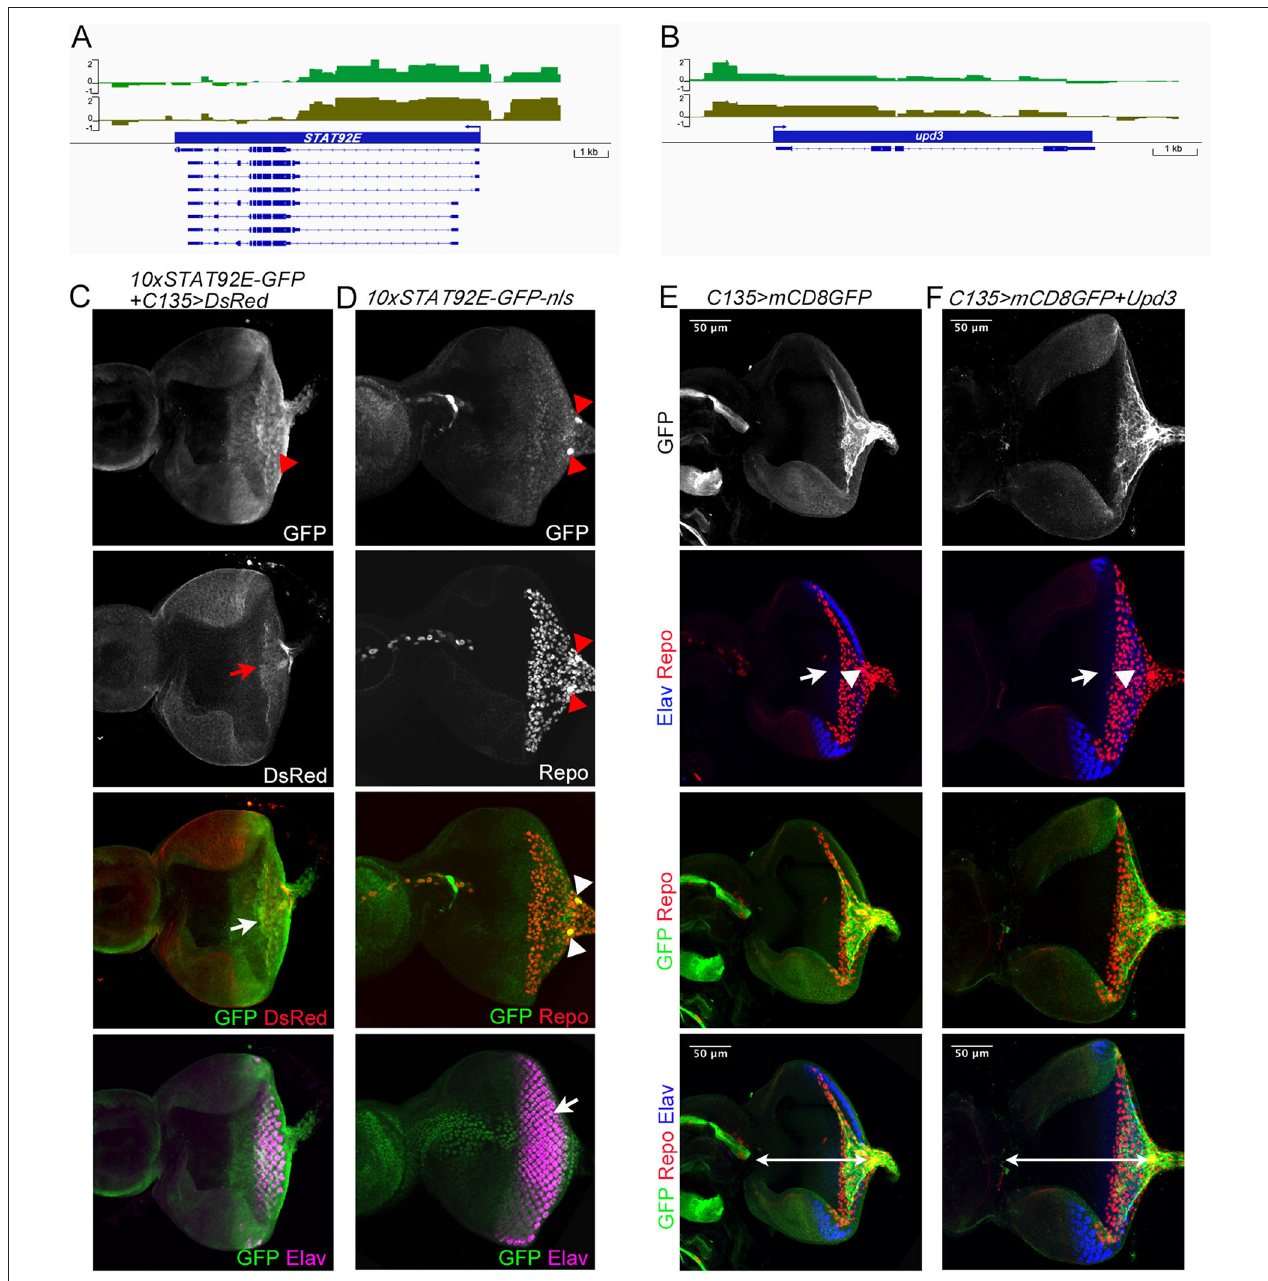
FIGURE 6 | Characterization of Dam-Pol II-bound genes: STAT92E and upd3 . (A,B) Dam-Pol II occupancy in the STAT92E (A) and upd3 (B) loci. Both biological replicates are shown in light and dark green. Scale bars on the y -axis represent the log 2 ratio change between Dam-Pol II and Dam samples. (C) A STAT92E activity reporter containing 10 STAT92E binding sites (10 × STAT92E-GFP) was crossed with C135-Gal4 driving UAS-DsRed labeling the membrane of carpet glia. GFP is expressed in the cytoplasm. The disc shown is a z-projection image and stained for the presence of GFP (green), DsRed (red), and Elav labeling differentiated PRs (magenta). The red arrowhead indicates the GFP punctate. The red arrow indicates the carpet glia membrane, and the white arrow indicates the colocalization of GFP and DsRed signals. (D) A modified STAT92E activity reporter whose GFP reporter is nucleus localized (10 × STAT92E-GFP-nls). The disc shown is stained for the presence of GFP (green), Repo (red), and Elav (magenta). The merged GFP and Repo image is a z-projection of basal focal planes, and the merged GFP and Elav image is the same eye disc with a z-projection of apical focal planes. Red and white arrowheads indicate the carpet nuclei. The white arrow indicates the colocalization of GFP and Elav signals. (E,F) All discs stained for the presence of carpet glia membrane (GFP staining, green), glial nuclei (Repo staining, red), and differentiated PRs (Elav staining, blue). Upd3-expressing eye discs (F) and control discs (E) at similar developmental stages (mid-third instar) are compared for disc size, which is measured by the length of the disc midline indicated by the white line. Upd3-expressing discs: 153 ± 2.7 µ m, n = 10; control discs: 126 ± 3.6 µ m, n = 8 (mean ± SD, n = disc number, p < 0.001, Student’s t -test). Rows of images are arranged as Figure 4 . White arrows and arrowheads in both (E,F) indicate the Elav-stained PRs and the Repo-stained glial nuclei,